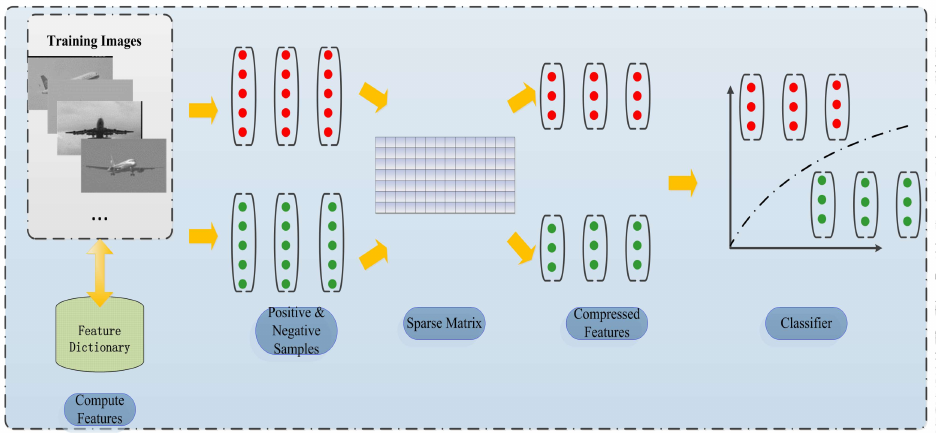
Figure 5. All of the feature vectors were compressed by a sparse matrix, and the compressed feature vectors were adopted to build the